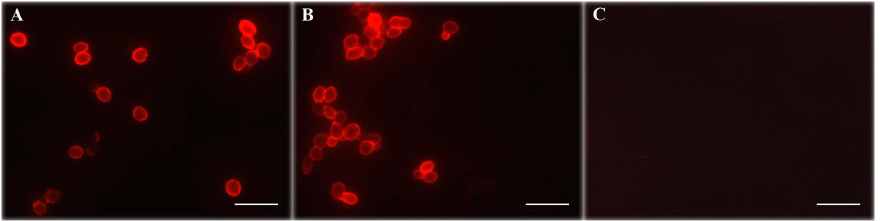
Figure 1. Invitro detection of Wa KT by IFA assay using mAbKT4. Free yeast cells of W. anomalus strains Wa F17.12 (A), Wa ATCC 96603 (B) and Wa UM3 (C) are shown. Red signal shows Wa KT concentrated in the yeast cell wall layers of Wa F17.12 (A) and Wa ATCC 96603 (B) (bars=20 m m). Phace contrast of panels A, B and C are shown in Figure S6.